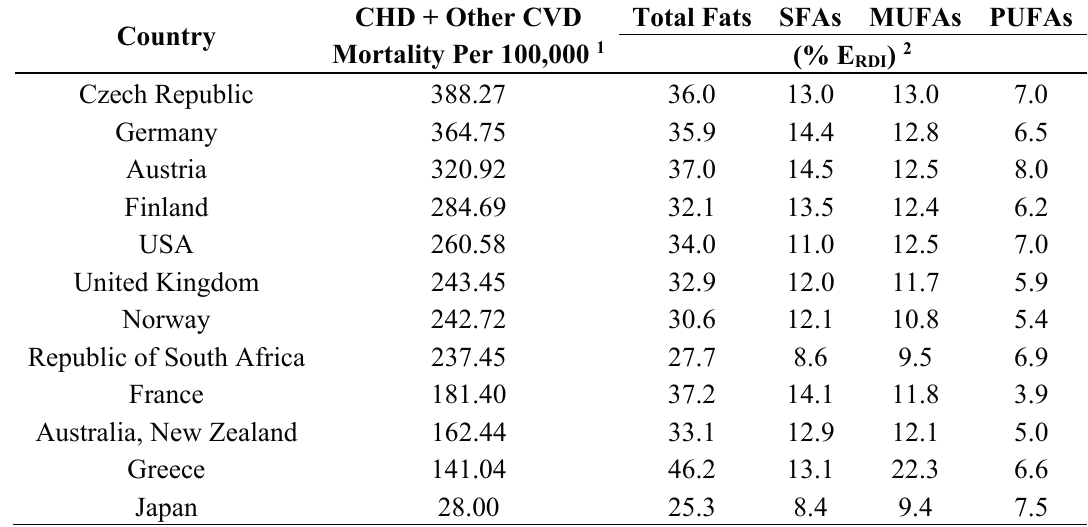
Table 4. CHD and CVD mortality and intakes of total fats, SFAs, MUFAs and PUFAs of an adult in various